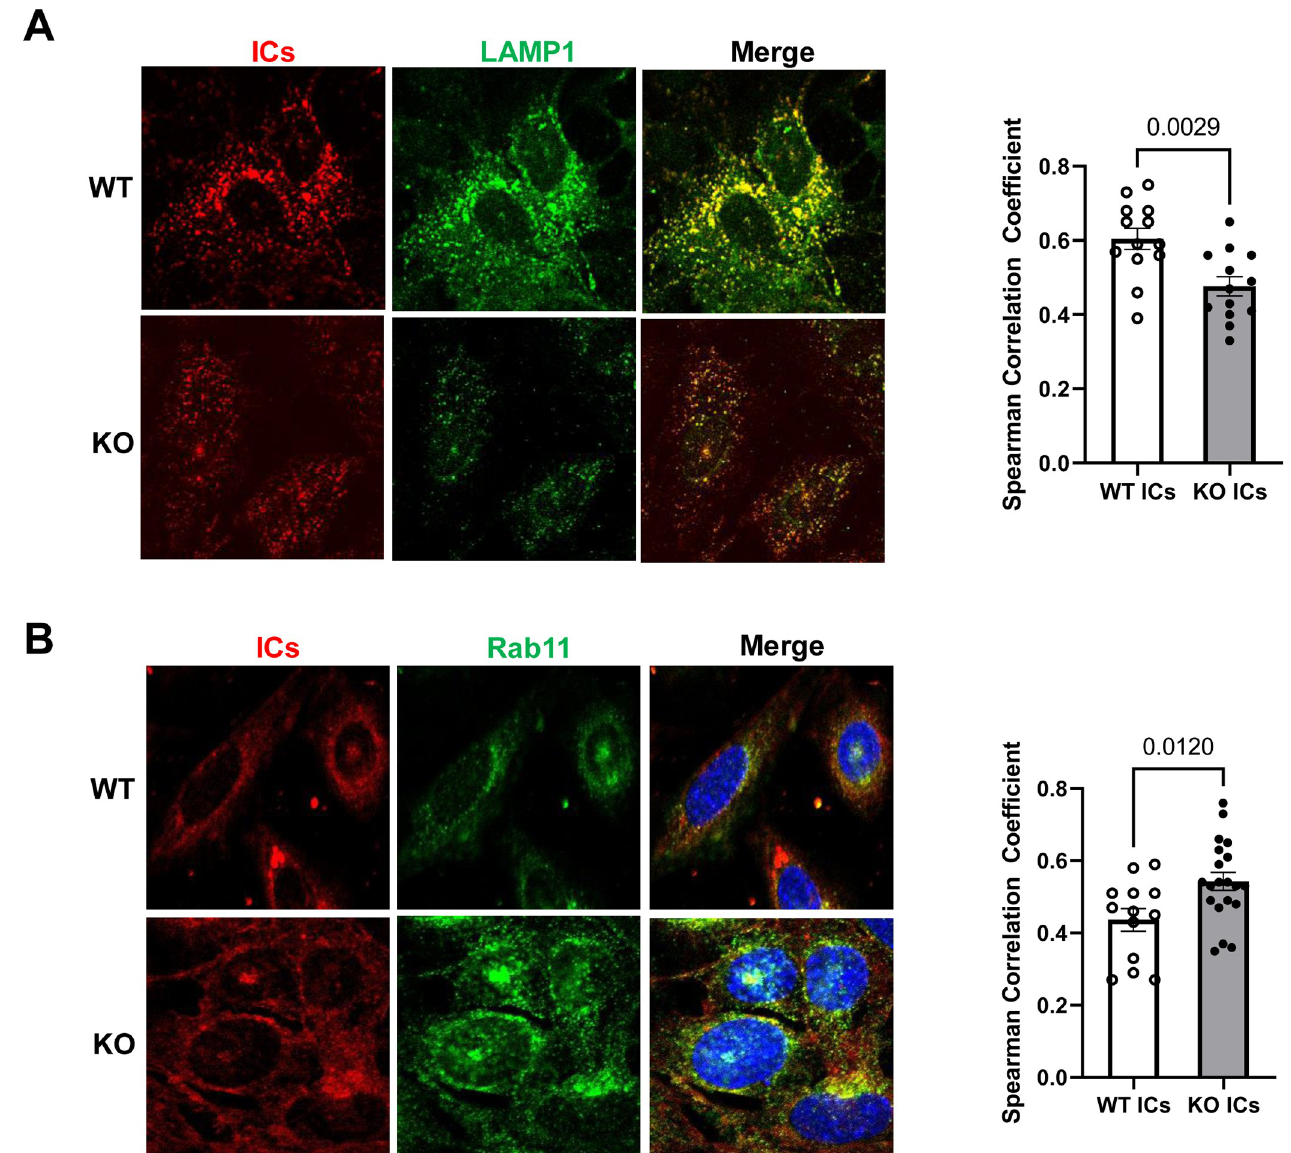
Fig 1. Knockout of FcRn in cultured podocytes significantly decreases immune complex trafficking to the lysosome and increases IC trafficking to recycling endosomes. A, Colocalization between lysosomes (LAMP1+ compartments) and immune complexes in WT or KO podocytes. B, Colocalization between recycling endosomes (Rab11+ compartments) and immune complexes in WT or KO podocytes. Each point on the graph represents the average correlation coefficient for 2–4 cells from n = 4 independent experiments.